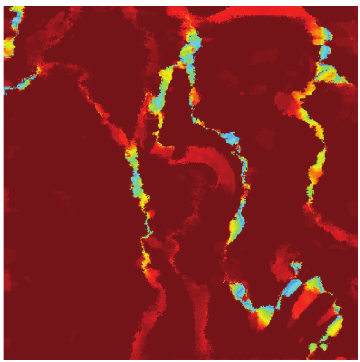
Figure 16: Number of depth values that are di ff erent from the chosen reference depth map when varying λ . Warm colors indicate an estimation independent of λ . Cold colors indicate more dependence.